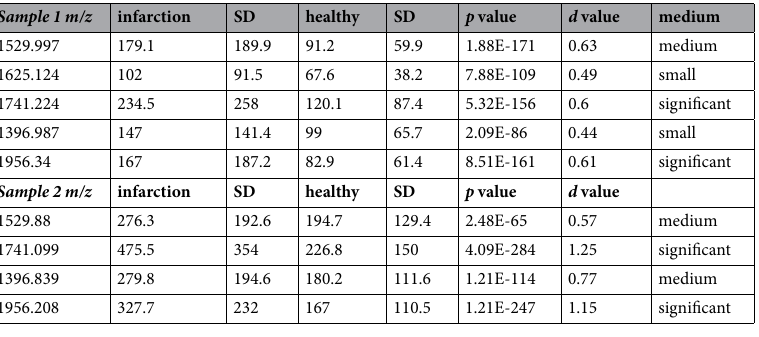
Table 1. Comparison of ROI analysis between the infarcted and healthy regions of the